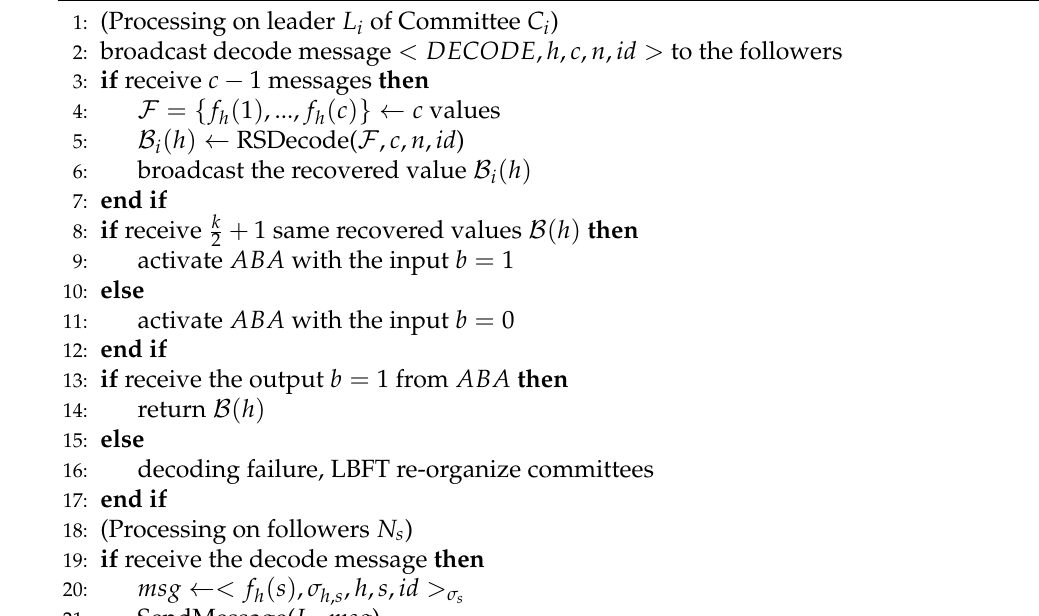
Algorithm 2 Data Recovery of a Certain Block.